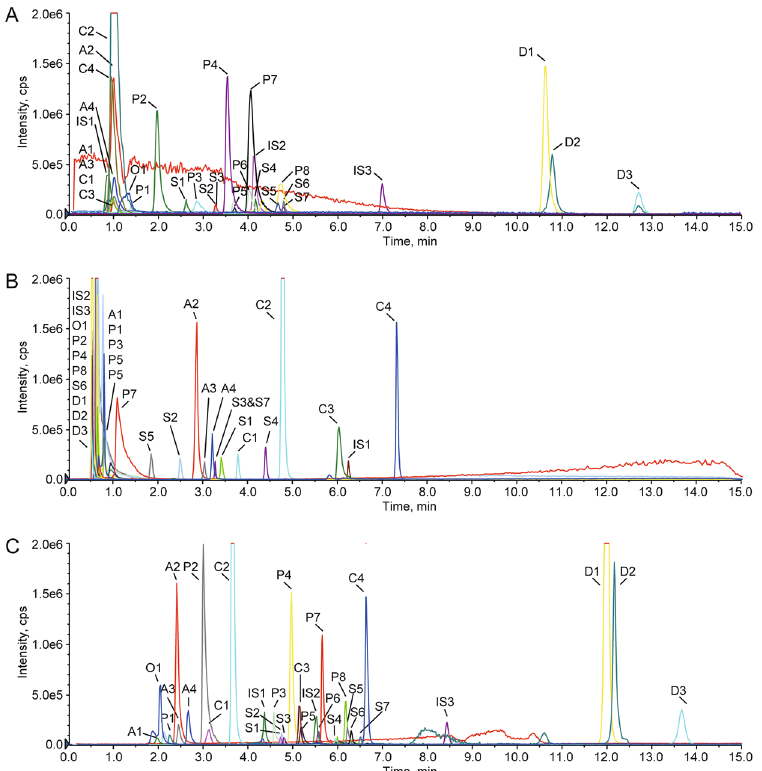
Figure 3. Representative total ion current (TIC) chromatograms in MRM mode for Dan-Qi pair extract and three internal standards using RPLC-MS/MS analysis (XR-ODS column) ( A ), HILIC-MS/MS analysis (BEH Amide column) ( B ), and RP-HILIC-MS/MS analysis ( C ), respectively. The analyte abbreviations are given in Table